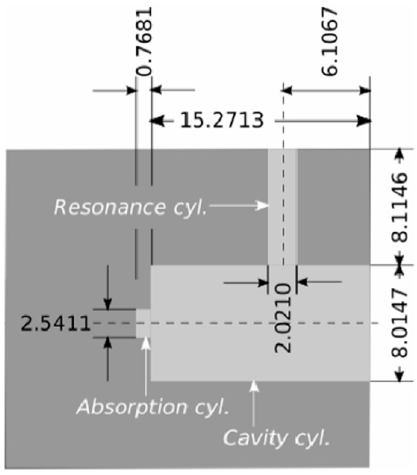
Figure 2. Cross-section of the T-cell resonator (light gray) showing the size of each cylinder in mm. The dimensions of the cells are the mean values obtained from a high precision measurement of the resonator [14].